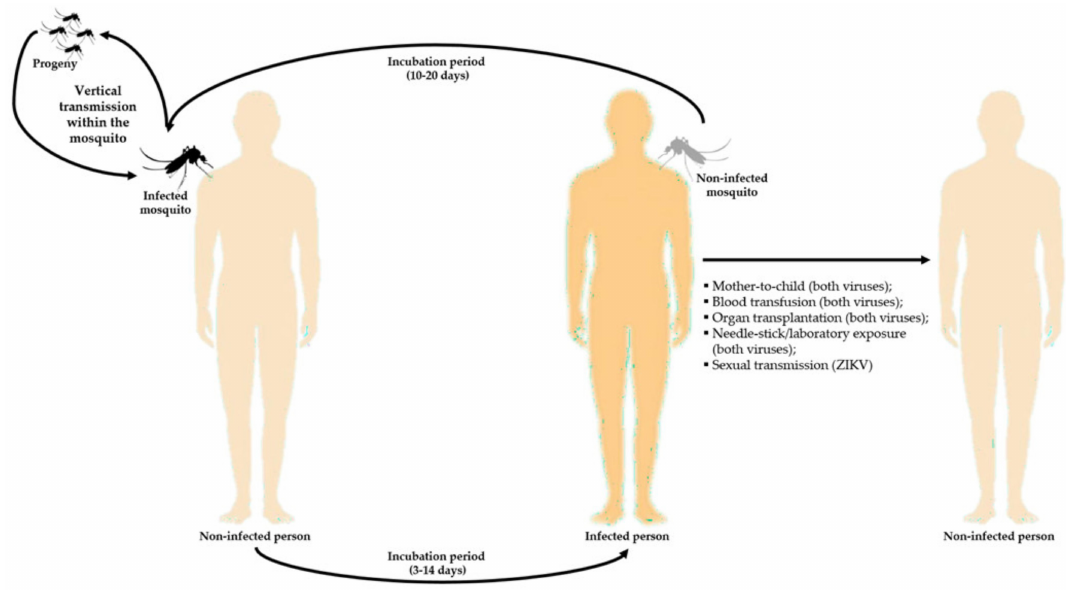
Figure 7. Modes of transmission of DENV and ZIKV. The main mode of transmission for both viruses is horizontal transmission (from infected mosquito to human). However, other modes have been suggested or reported, as well as vertical transmission (from an infected female mosquito to its